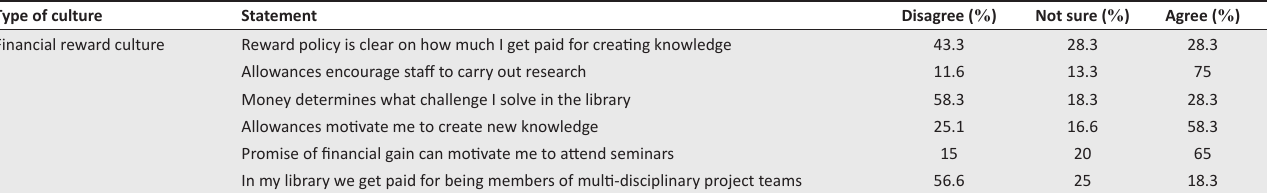
TABLE 3: Percentages for financial reward culture and knowledge